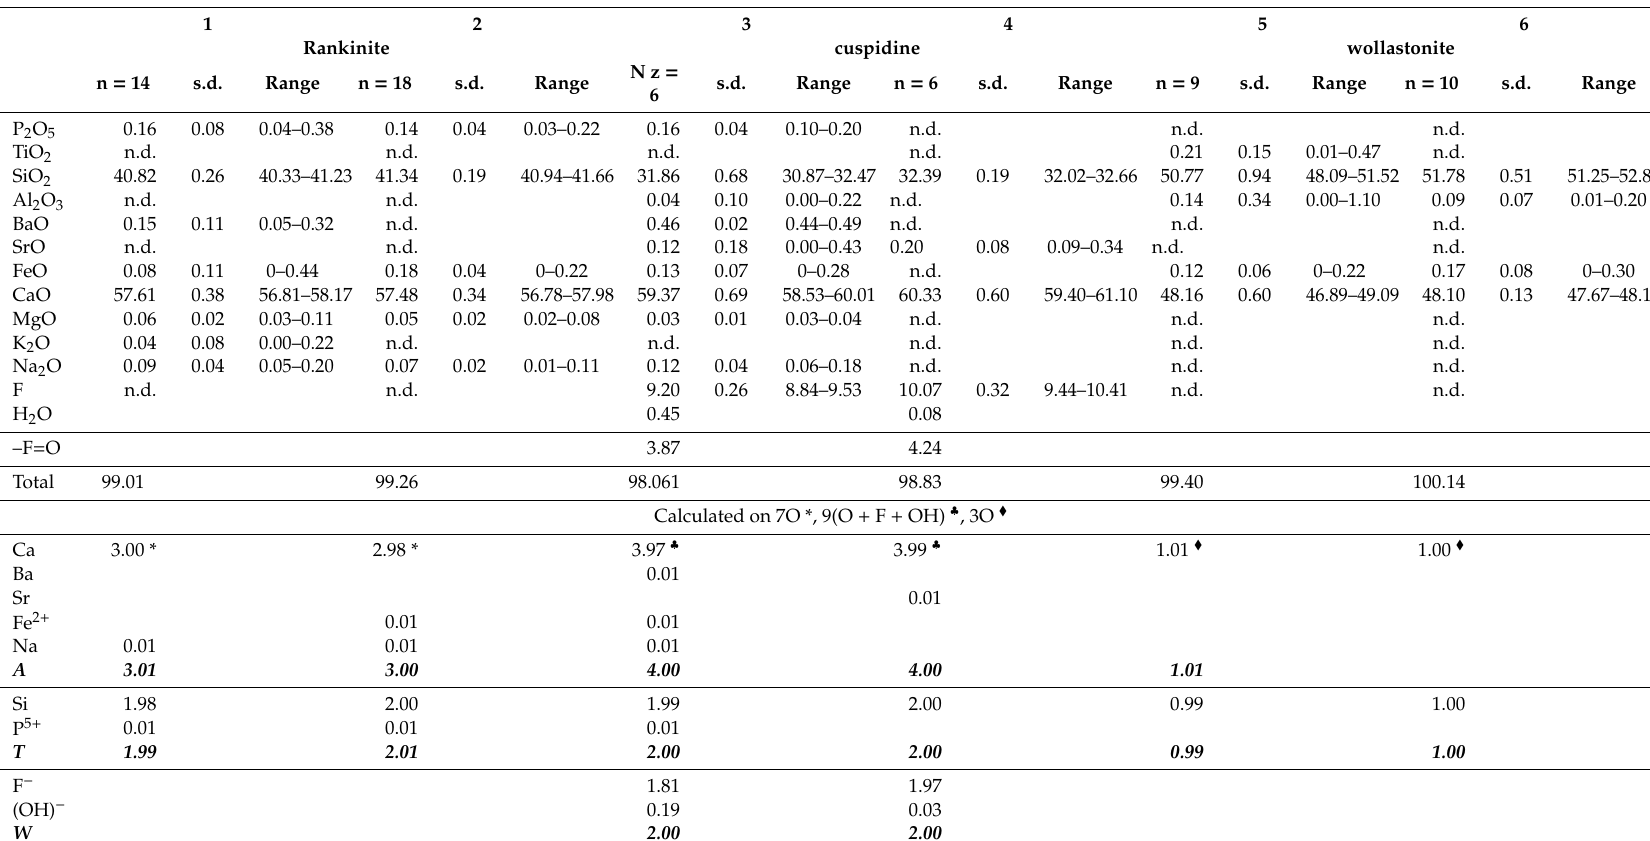
Table 8. Chemical composition of Ca-silicates from Zuk Tamrur (1, 3, 5) and Gurim Anticline paralava (2, 4, 6),